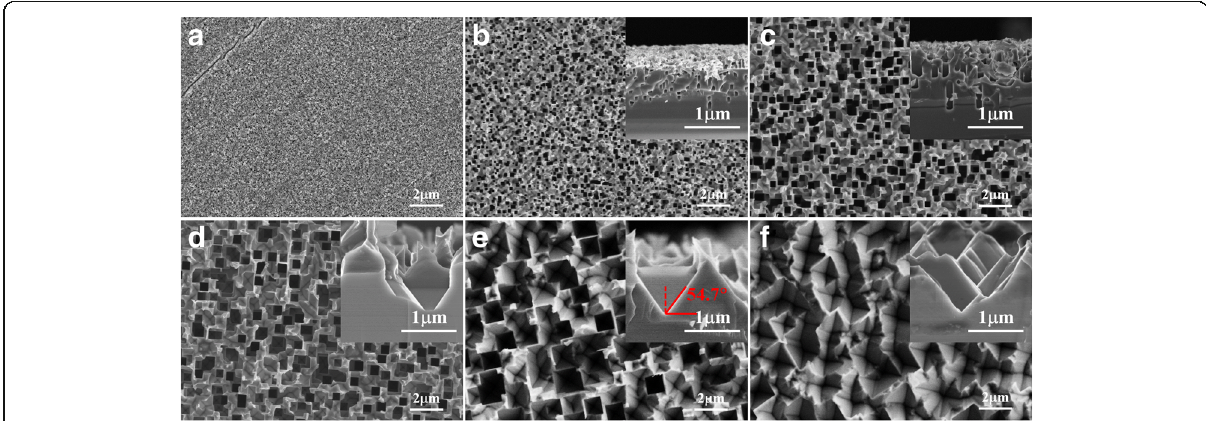
Fig. 4 SEM images of inverted pyramid (cross sections in insert) processing for different time. SEM images: a nanoporous silicon and b – f inverted pyramid surface-section and cross section texturing at 60 °C in aqueous NaOH solution for 1, 3, 5, 7, and 9 min,